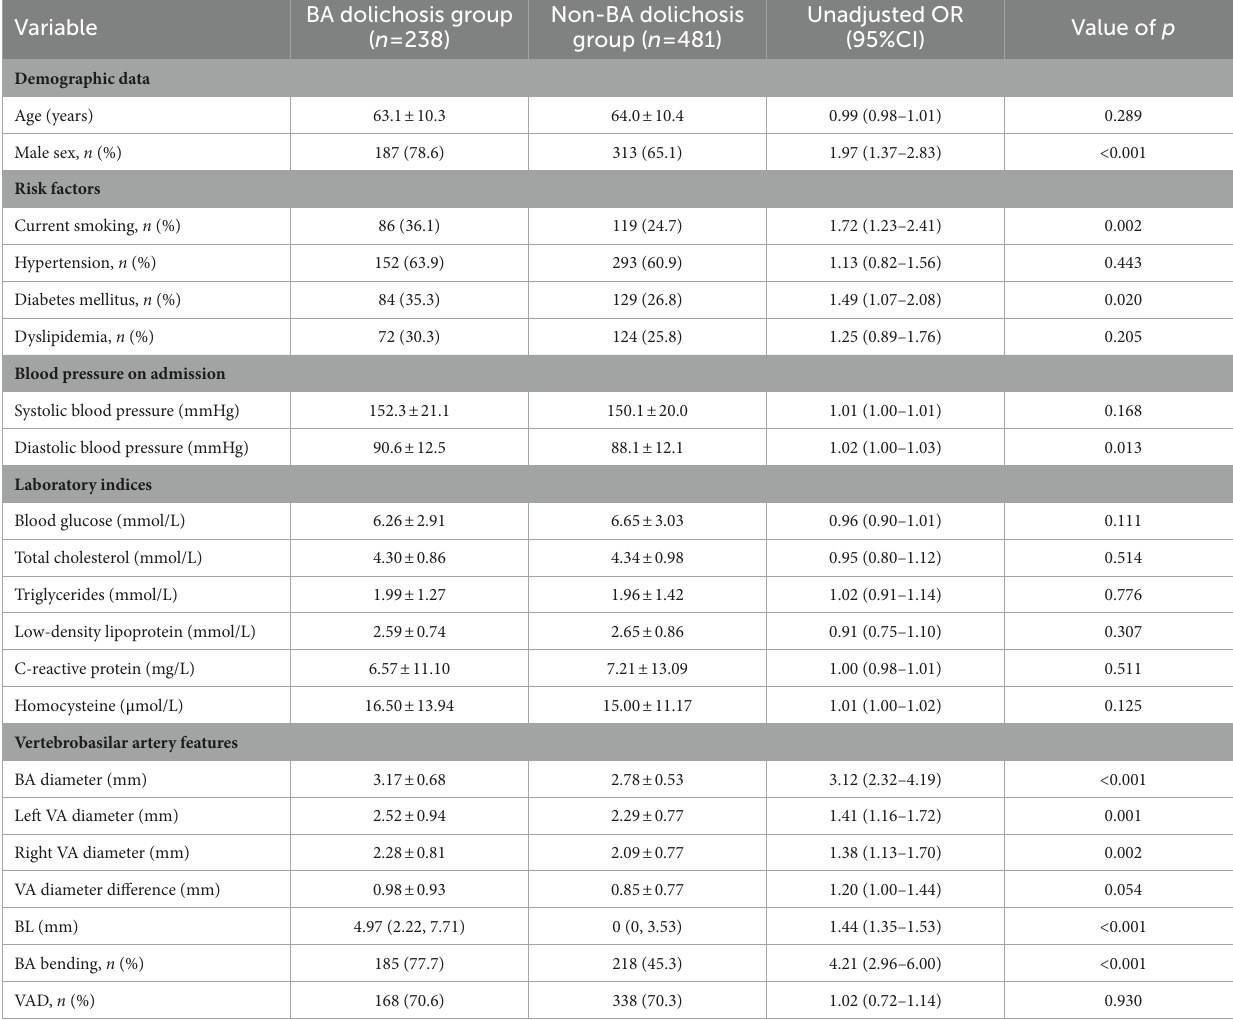
TABLE 1 Univariate logistic regression analysis of factors associated with BA dolichosis in patients with ACI.